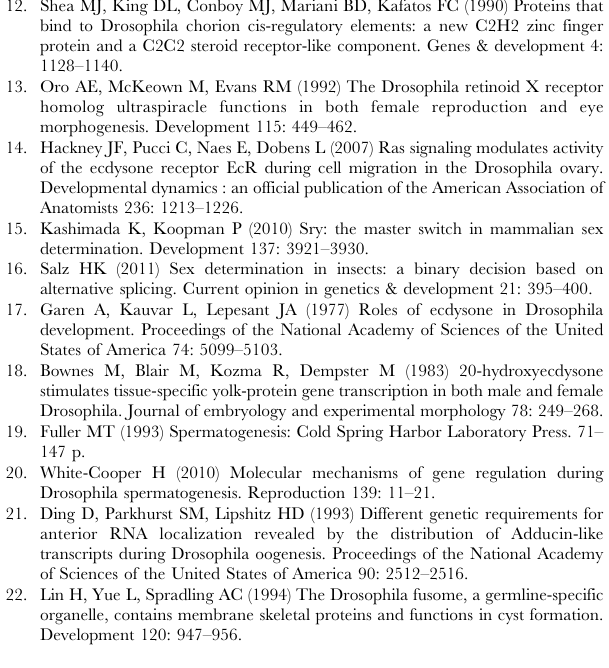
Figure S1 c587 GAL4 drives RNAi mediated knock down